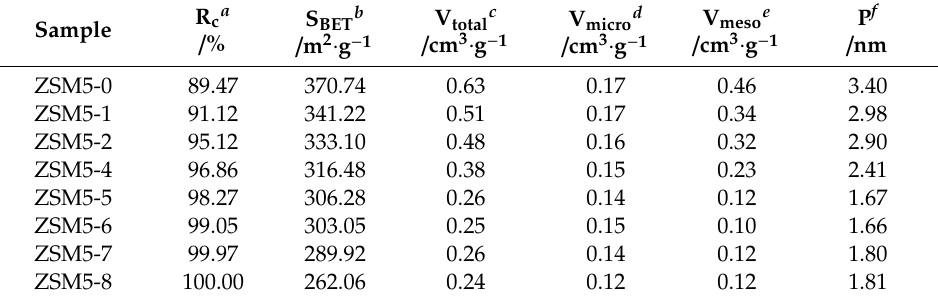
Figure 4. XRD patterns of ZSM-5 zeolite synthesized with different ethanol concentrations. Table 1. Textual properties of ZSM-5 zeolites prepared with different ethanol concentrations.